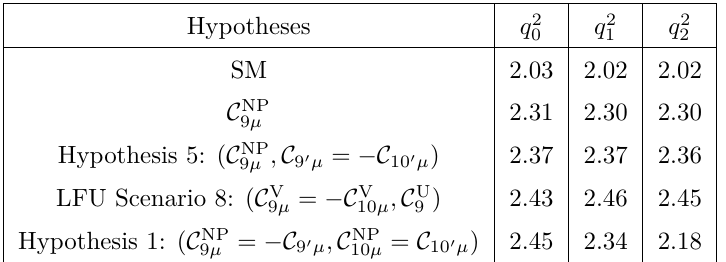
Table 1 . Position of the zero evaluated from: a) Re( A ⊥ ( q 2 and c) the exact position given by X 2 ( q 2 currents that do not fulfill condition R , as in Hypothesis 1 [2], do the zero points differ significantly from one